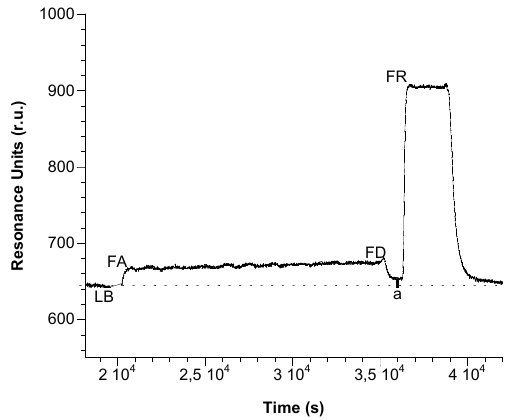
Figure 2. Example of sensorgram obtained with a sandwich format. For each measurement, after checking the original baseline ( LB ) by flowing phosphate buffer 50 mM, pH 7.2, the analyte that flowed into the system upon the steady state has been reached ( FA ); then, the dissociation step ( FD ) started by flowing again phosphate buffer (the small bold line ( a ) indicates the Δ r.u, relative to the formation of the immunocomplex between analyte and bioreceptor); the regeneration step ( FR ) was performed by glycine-HCl solution pH 2.4 inally the phosphate buffer to obtain the baseline.